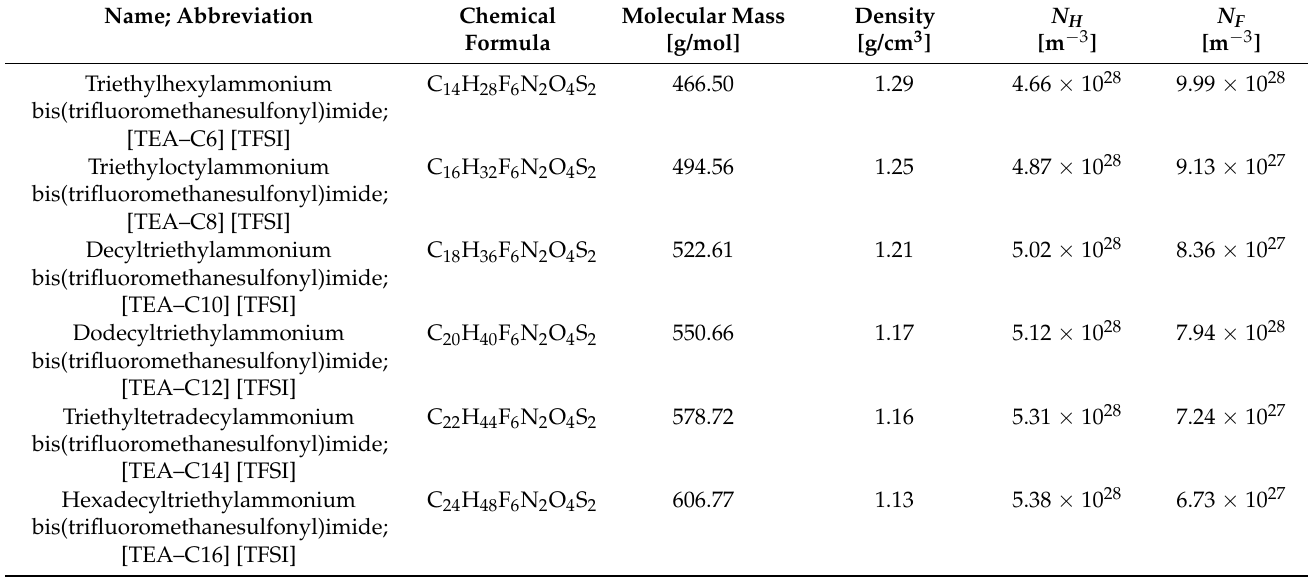
Table 1. Properties of the series of ionic